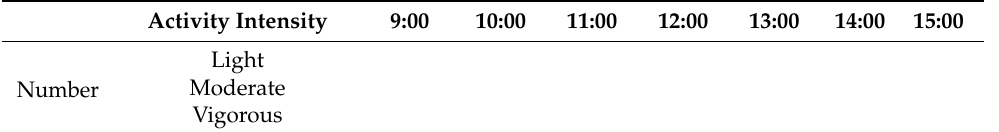
Table A1. Activity record.